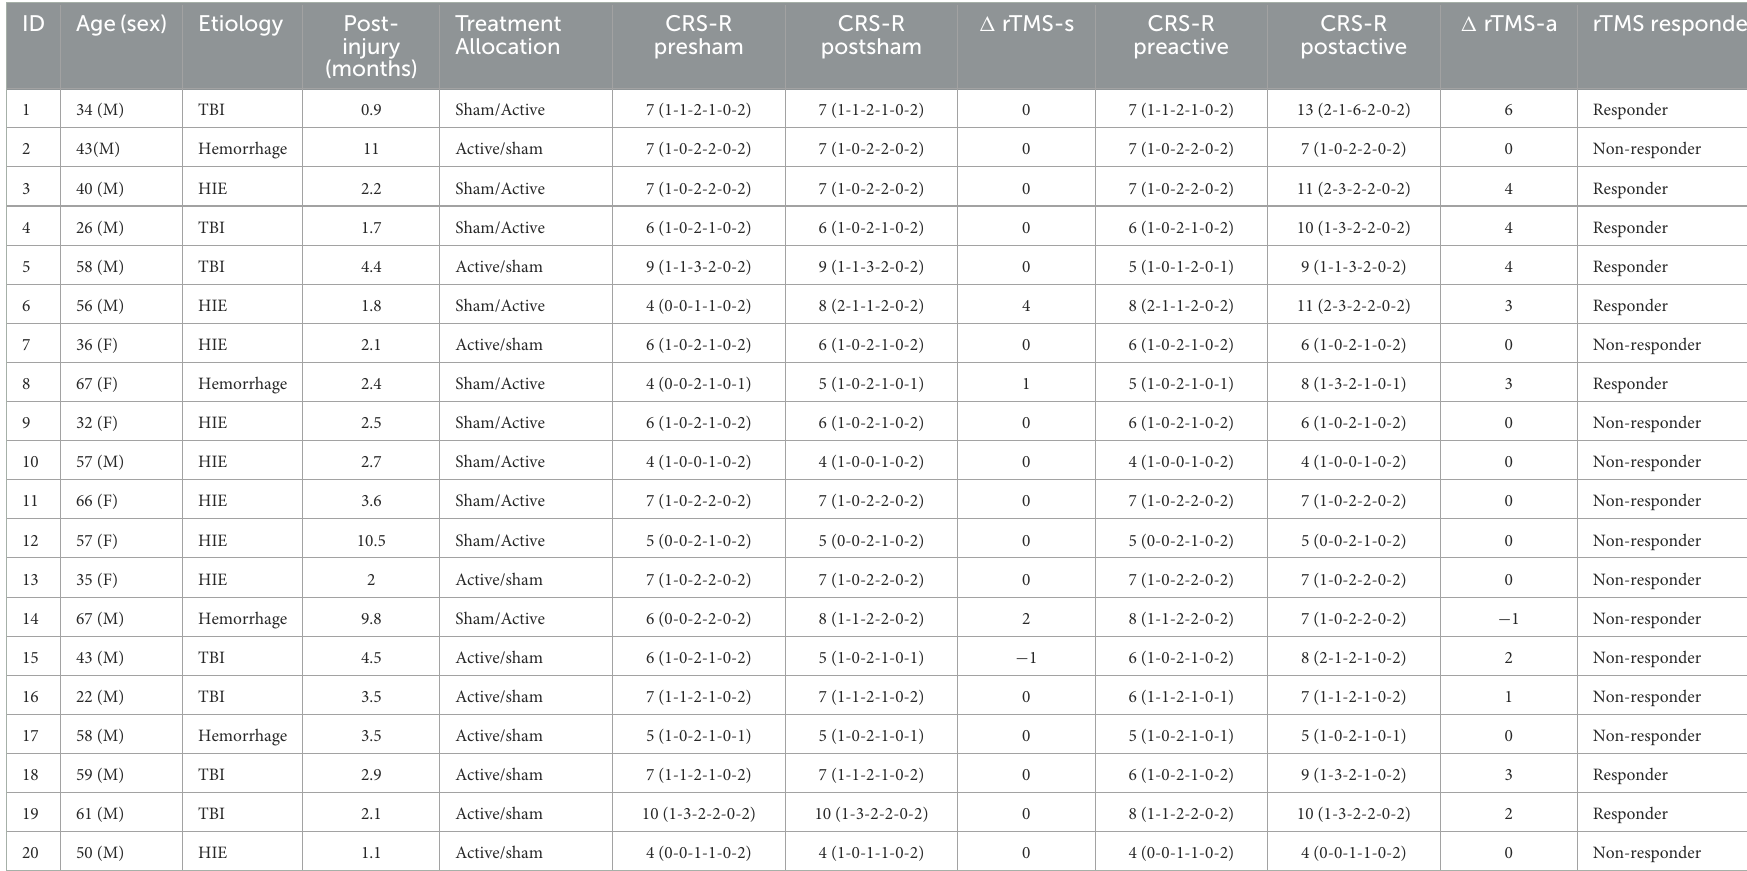
TABLE 1 Demographic and clinical information of